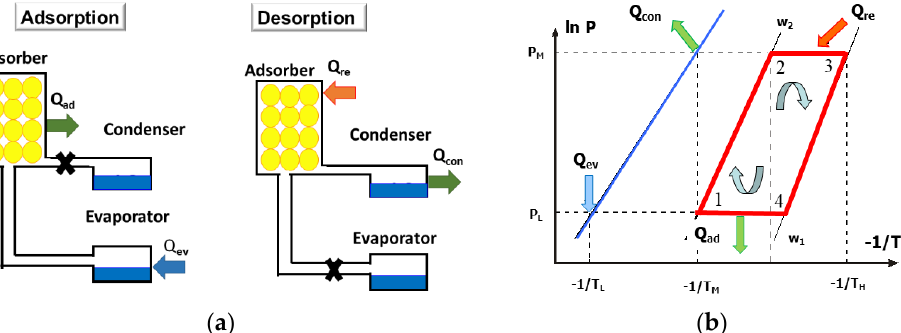
Figure 1. Typical scheme ( a ) and working cycle ( b ) of AHT unit. Isobaric adsorption (4 − 1) and desorption (2 − 3) and isosteric heating (1 − 2) and cooling (3 − 4) stages; w 1 and w 2 − isosters of water vapor adsorption on the adsorbent with minimum and maximum uptakes, respectively. Reprinted/adapted with permission from Ref. [16]. Copyright 2018, Elsevier.